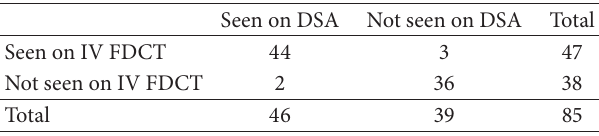
Table 3: Accuracy of IV FDCT in identifying hemodynamic significant vasospasm ( > 50%) compared with